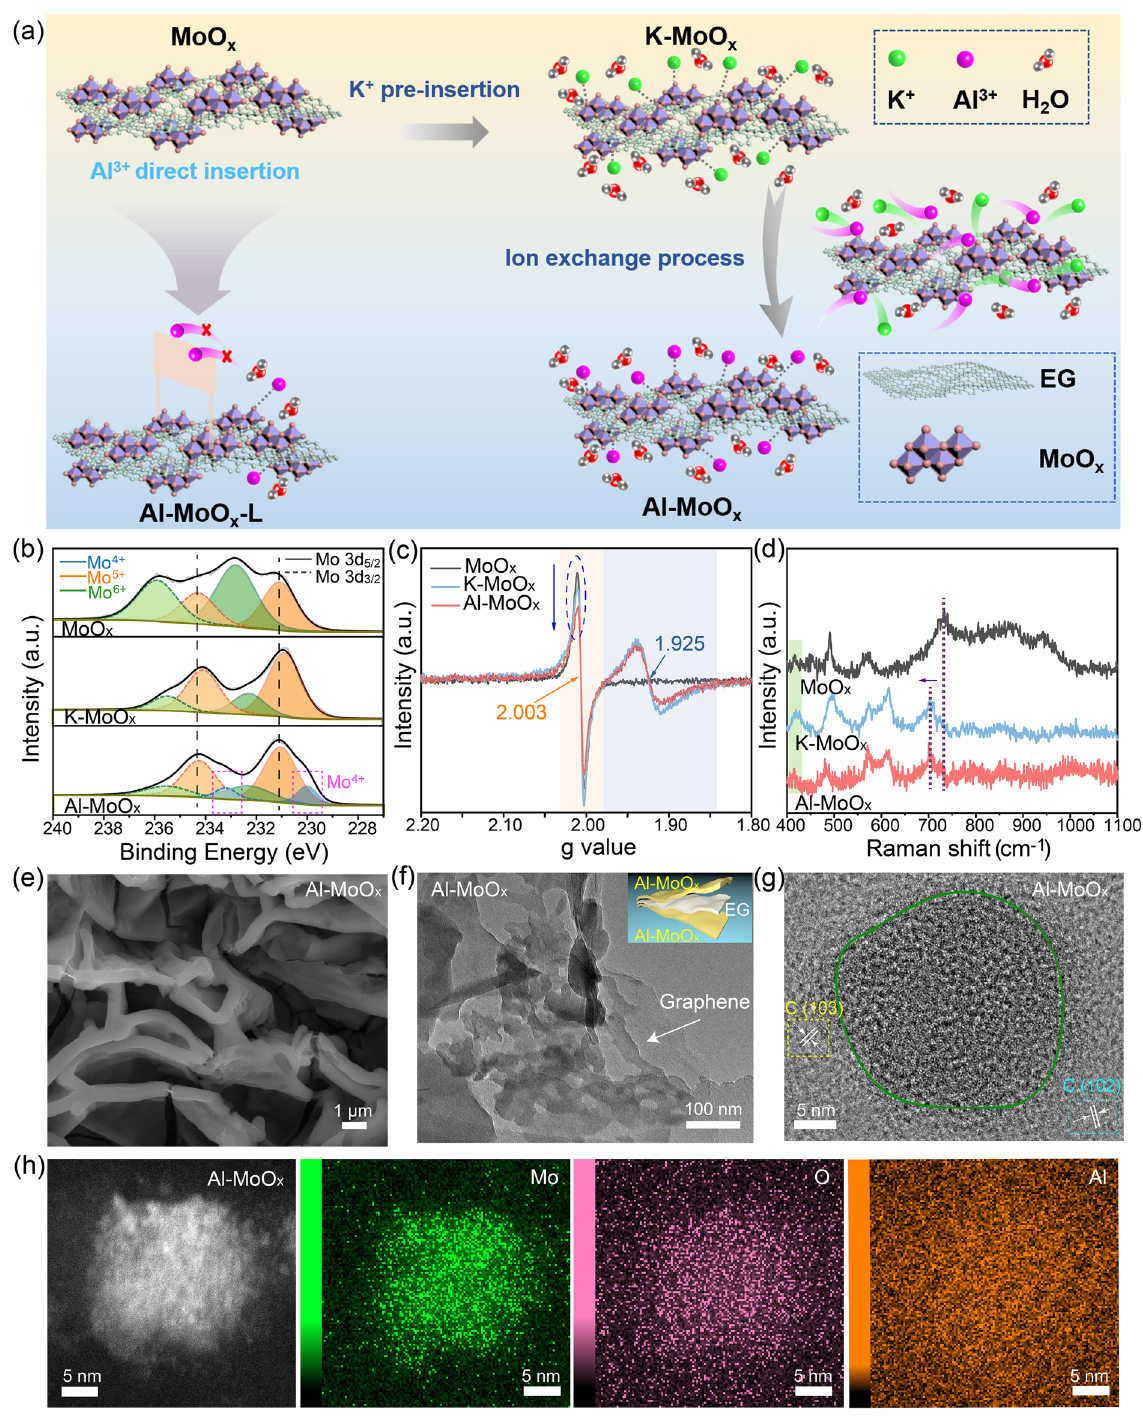
Fig. 1 Design and structural characterization of Al-MoO x . a Schematic illustration of the design and preparation of Al-MoO x from ion exchange and Al-MoO x -L from direct insertion. b Mo 3 d XPS, c EPR and d Raman spectra of MoO x , K-MoO x and Al-MoO x . e SEM, f low- resolution bright-field TEM (with the structural schematic as the inset), g HRTEM, h STEM images and the corresponding elemental mappings of Mo (green), O (pink) and Al (orange) for Al-MoO